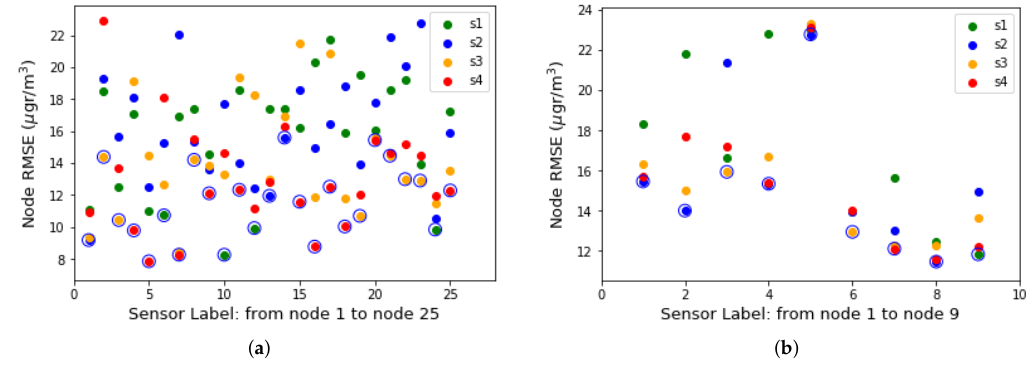
Figure 4. RMSE classified by testbed and node: ( a ) Spanish Testbed, ( b ) Italian